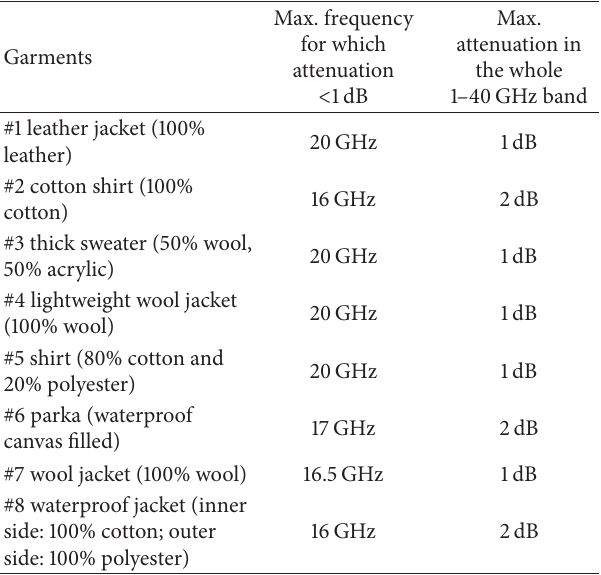
Table 1: Results on transmission tests on